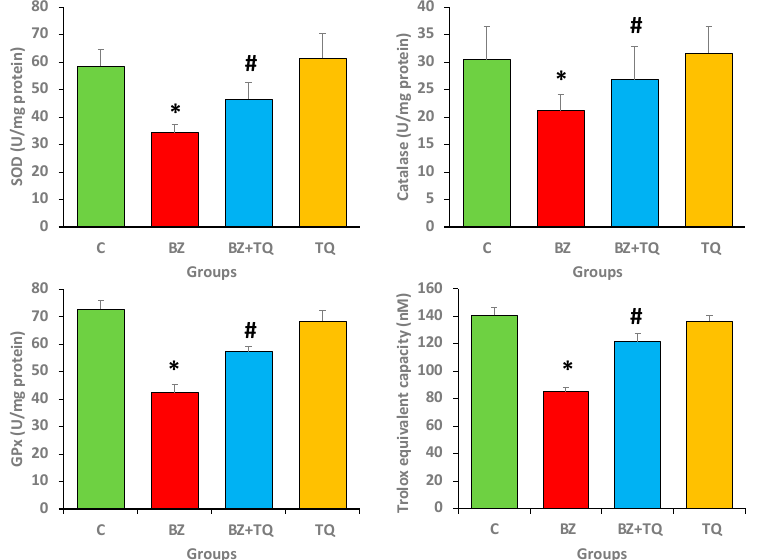
Figure 4. Catalase, SOD, GPx, and overall antioxidant capacity were considerably reduced in the group treated with only B(a)P in comparison with the control group. The activities of these enzymes significantly recovered after treatment with TQ. The numbers signify the mean ± SEM, with 8 rats/group. The statistical differences are denoted with an asterisk (*), indicating significance at p < 0.05 in comparison with the control group, and a hashtag (#), signifying p < 0.05 in comparison with the disease control.